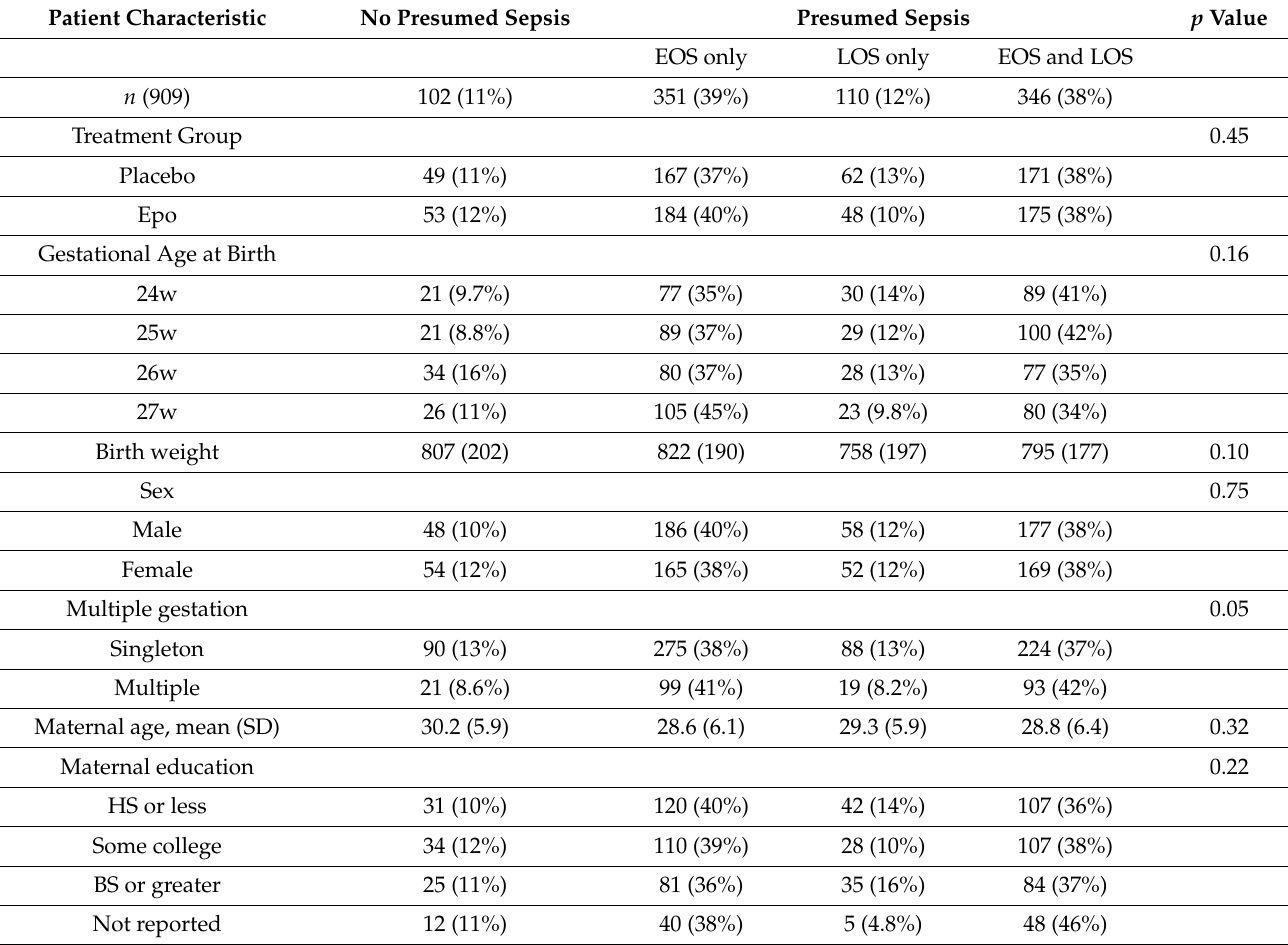
Table 2. Demographics by timing of presumed sepsis